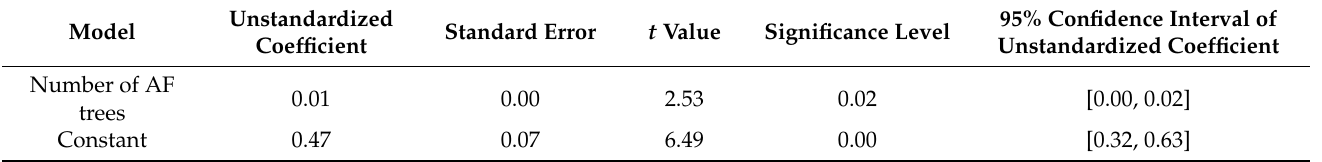
Table 2. Linear regression model between temporary stability (dependent variable) and the number of Abies faxoniana (AF) trees (independent